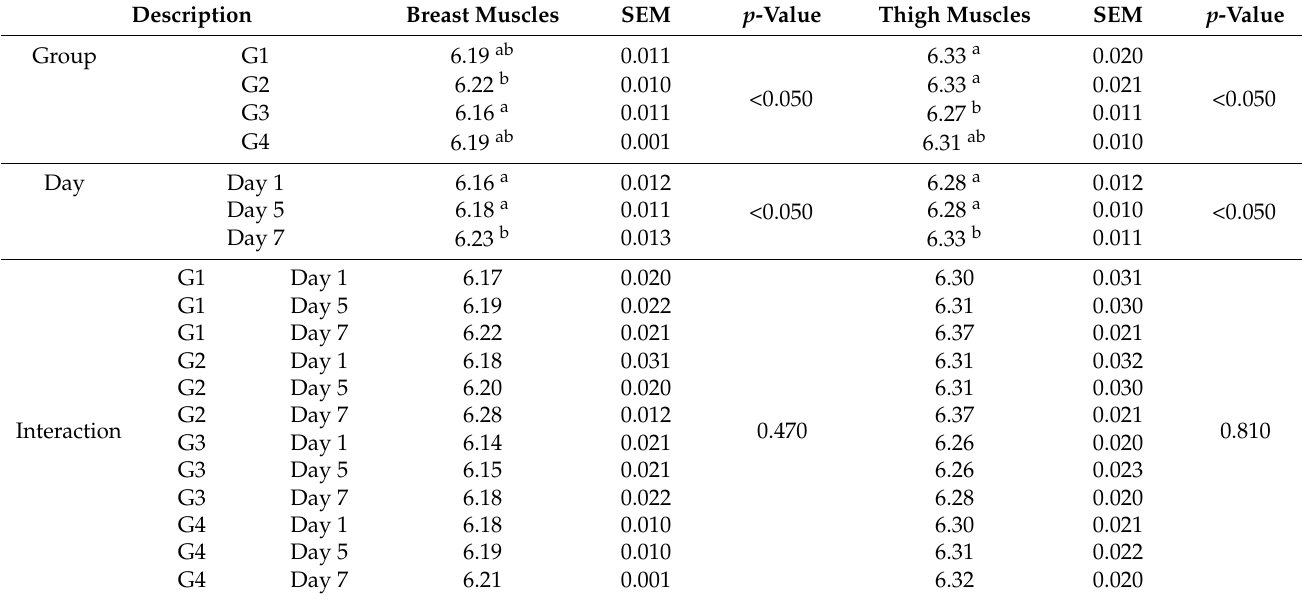
Table 4. pH of breast and thigh muscle of fresh chickens and chickens refrigerated for up to seven days. Description Breast Muscles SEM p -Value Thigh Muscles SEM p -Value Group